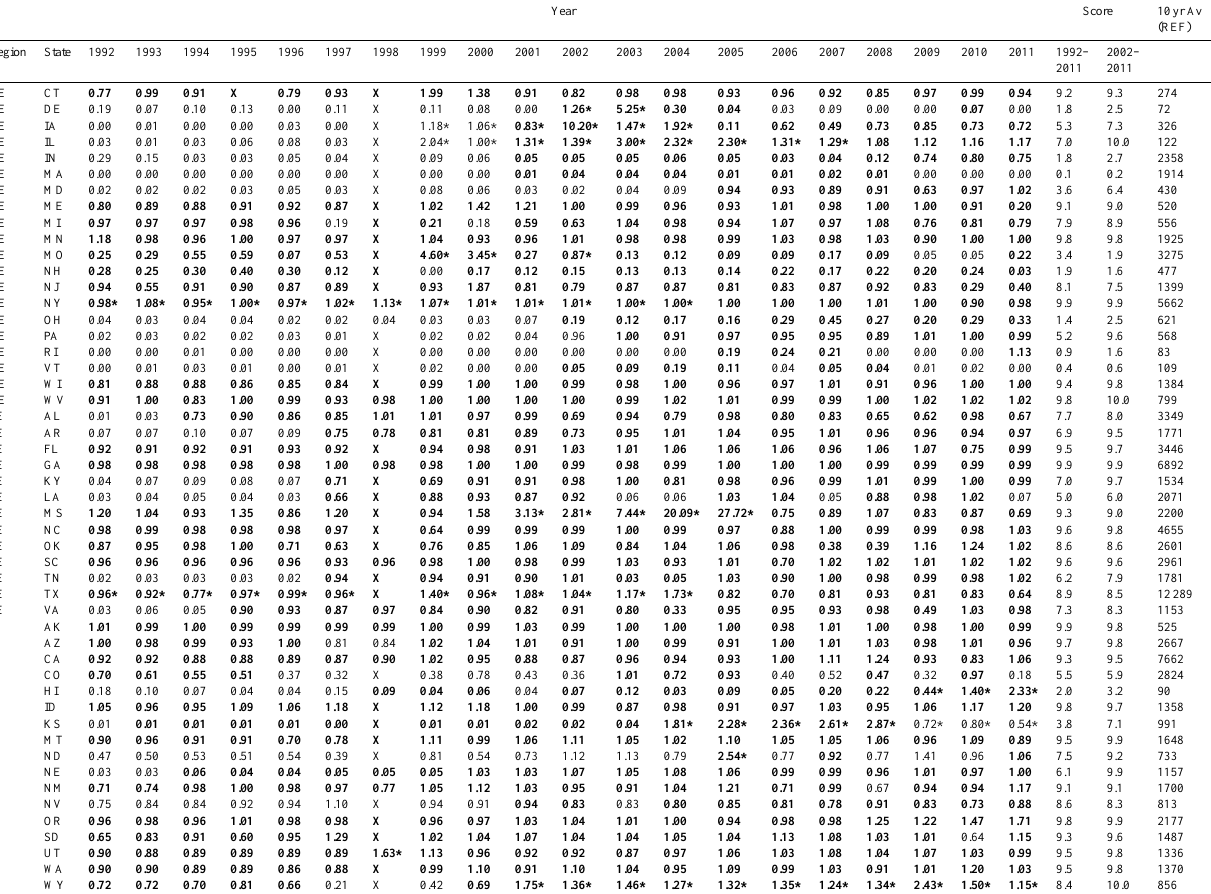
Table 9. Ratio of the number of wildfires estimated, by US state and year, from the FPA FOD to that from the USFS / NICC reference source. Boldface indicates cases in which at least some viable and non-redundant data were available from the non-federal systems of record and were included in the final FOD. Entries of “X” indicate years and states for which no reference estimate was available. Asterisks (*) indicate cases in which the reference estimate is evidently based on incomplete reporting and therefore biased low. Scores for the full 20yr period and the 10yr span, 2002–2011, and the 10yr average annual number of wildfires calculated from the reference source (REF) are also presented. States are grouped into the following regions, per the National Cohesive Wildland Fire Management Strategy: Northeast (NE), Southeast (SE), and West (W) (see USDI and USDA, 2012). Federal Information Processing Standards (FIPS) codes are used to identify states (NIST,